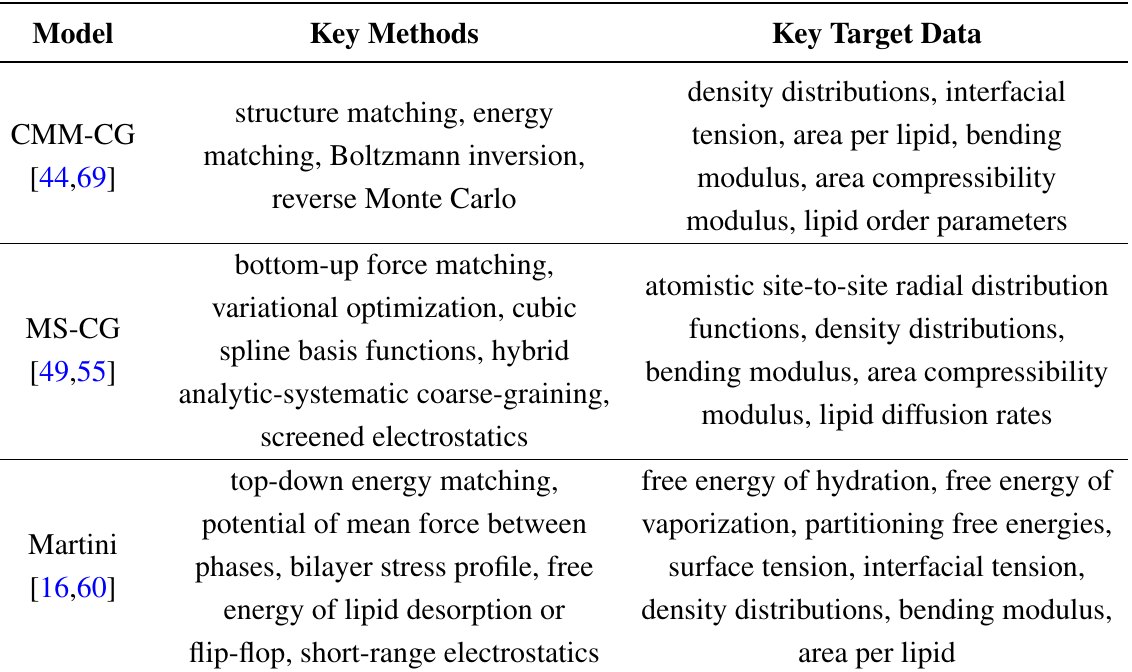
Table 1. Summary of key modeling calculations and target data for representative coarse-grained models discussed in Sections 2.2–2.4. This list is not exhaustive, however, and these models reproduce a wide range of experimental data. Key Methods Key Target